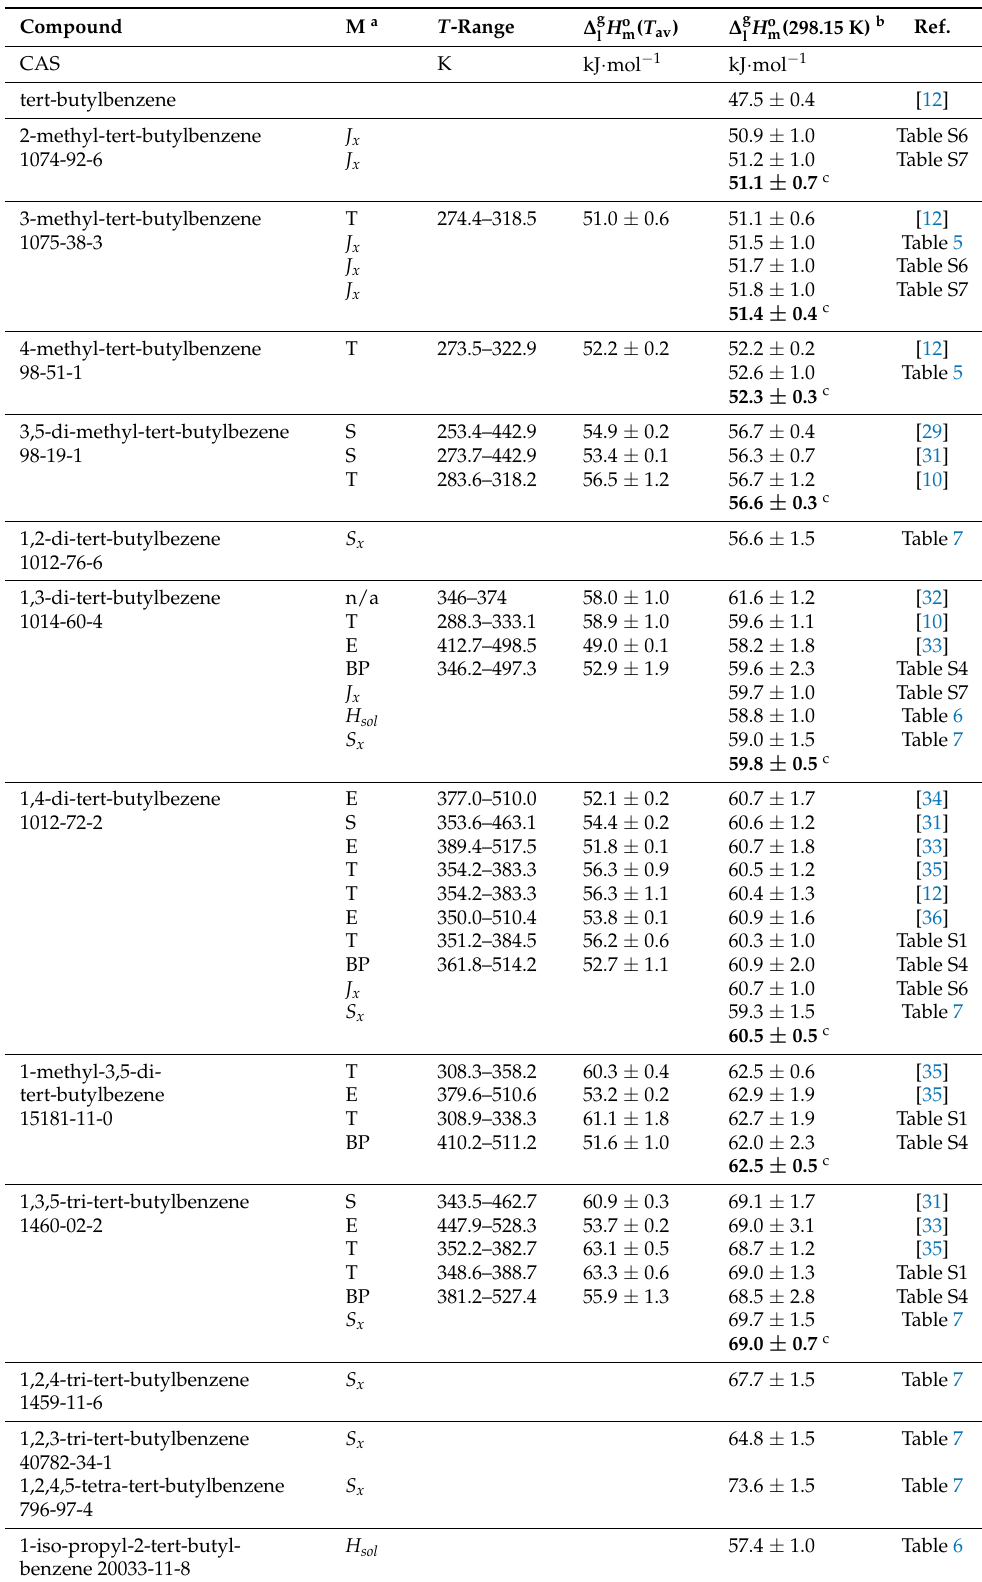
Table 2. Compilation of the enthalpies of vaporisation, ∆ g determined in this work and from the data available in the